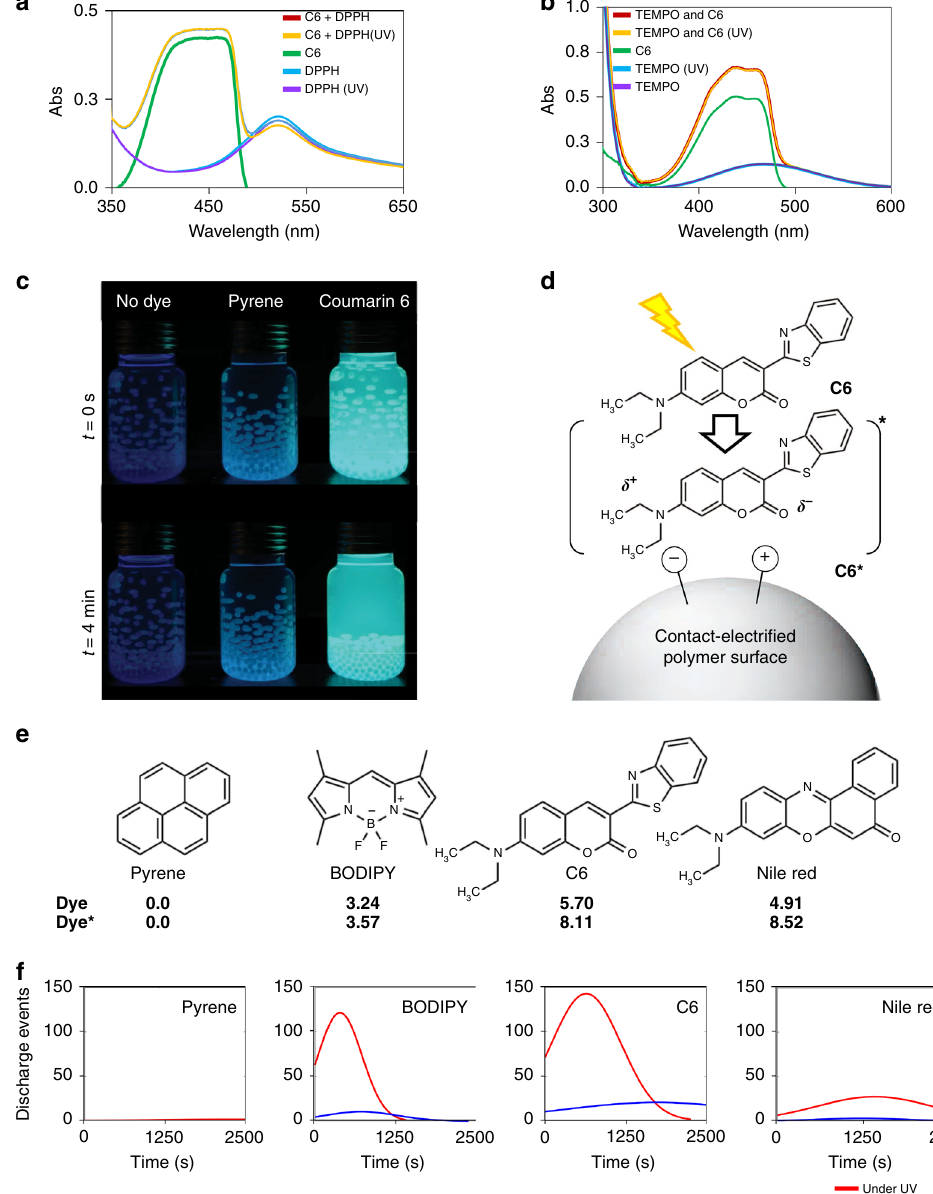
Fig. 6 Possible interactions upon light induced discharge. a , b Dye/radical interaction or reaction: UV – Vis spectra of the 10 min ultraviolet (UV) illuminated solutions of the example radicals with (1,1-diphenyl picrylhydrazyl (DPPH) (1 × 10 − 5 M) + Coumarin 6 (C6) (1 × 10 − 5 M) and 2,2,6,6-tetramethylpiperidine 1-oxyl (TEMPO) (1 × 10 − 5 M) + C6 (1 × 10 − 5 M)) show no change with those of the mixtures before illumination. (In a DPPH + C6 “ bleaching ” is to the same extent with the bleaching of the illuminated DPPH alone). Therefore, one can say that the discharging does not involve interactions/reactions of the dyes with the radicalic species on polymers. c Forty poly(tetra fl uoroethylene) (PTFE) beads in C6 solution (abs max 427 nm) discharge quickly when they are illuminated with UV light, whereas the same beads in pyrene solution (abs max 340 nm) do not discharge even after prolonged illumination with the same source. See also Supplementary Movie 6. (Both dyes = 1 × 10 − 5 M, dry hexane, tribocharged for 2 min). d An interaction between a highly polar excited state of C6 and the charges on the polymer surface may facilitate a possible electron transfer. e Calculated dipole moments of the photoexcited dyes in their ground and excited states. f Statistics from the discharging experiments shown in c . Data from fi ve independent experiments was collected (a total of 200 beads for each experiment, from which only the beads displaying “ discharge events ” were counted); curve fi t on data collected in experiments with (red) and without illumination (blue) was made by Matlab 2017 program using distribution function. For experimental details see Methods Surface resistivity measurements . Surface resistivities of PDMS, and dye-doped PDMS (1 × 10 − 5 M, see above for preparation details) the measured surface PDMS were measured using a two-probe method, with w = 5mm wide samples, resistivities were determined to be ca. 10 14 ohm sq − 1 . (Supplementary Figure 8). and the distance between electrodes d = 0.5 mm. I – V curves were collected on a Keithley electrometer (6517B), which served as the voltage source and also mea- sured the generated current. Applied voltage was changed from 0 to 100 V in steps Preparation of electrostatic self-assemblies . 20 PTFE and 20 POM beads were of 10 V. Using the slopes of the I – V curves, the values were calculated for surface introduced into a 1 ×10 − 5 M, dry hexane Coumarin 6 solution in a glass petri resistivity, Rs, according to equation Rs = (V/I) ∙ ( w / d ). For PDMS, and dye-doped dish, and the mixture was shaken for 1 min, until which time the assembly was NATURE COMMUNICATIONS| (2019) 10:276